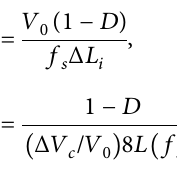
Figure 8: Resonant converter-based